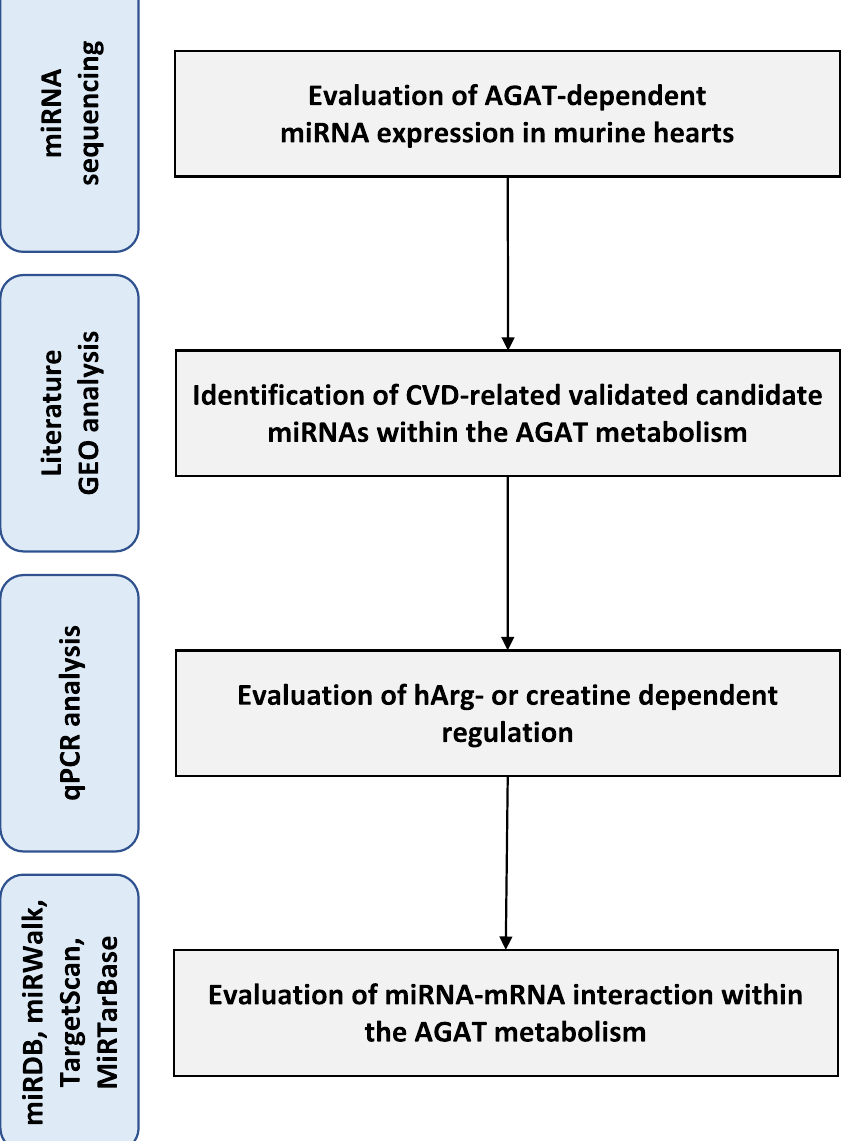
Figure 1. Overview of the methods and objectives of the different steps of the study design. CVD: cardiovascular disease; GEO: Gene Expression Omnibus; hArg: homoarginine; miRNA: